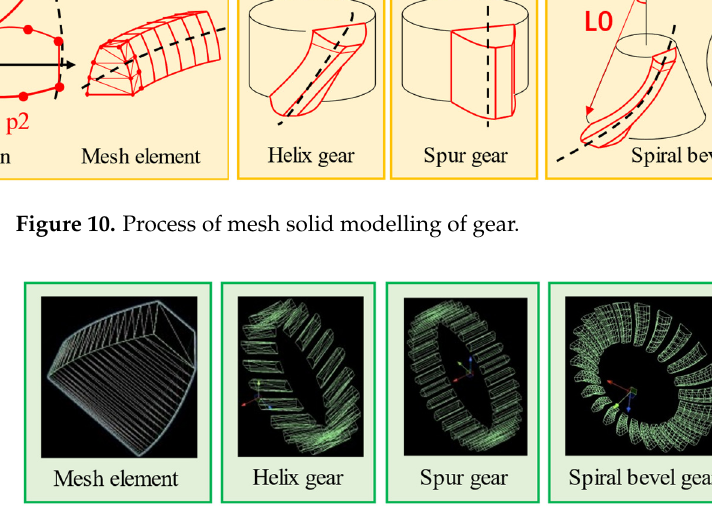
Figure 12. Arc feature mesh solid model.